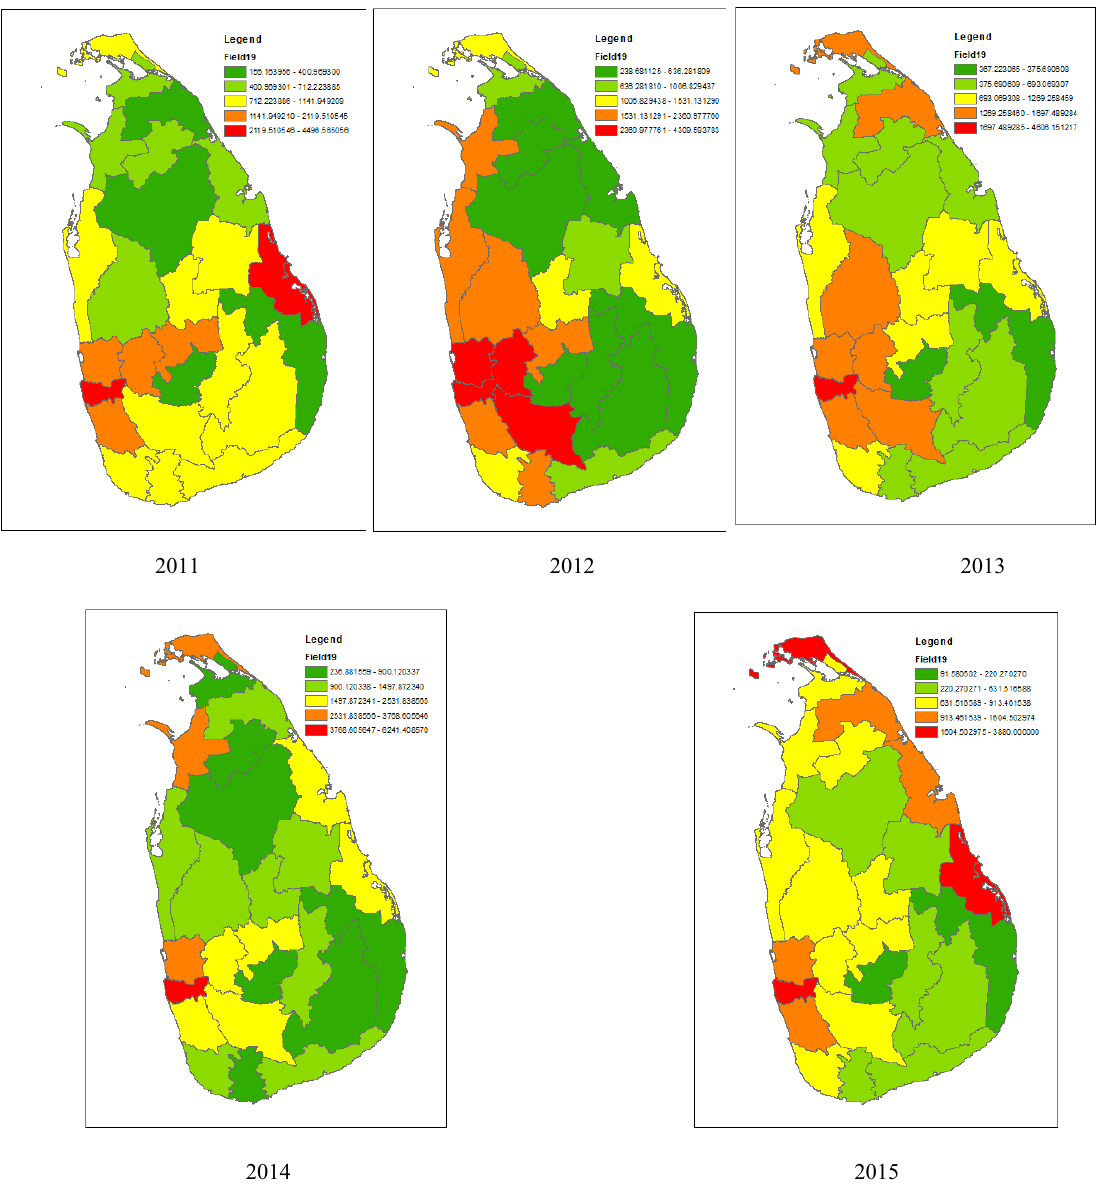
Figure 2: Spatial distribution of dengue incidence from 2011 to 2015 in Sri